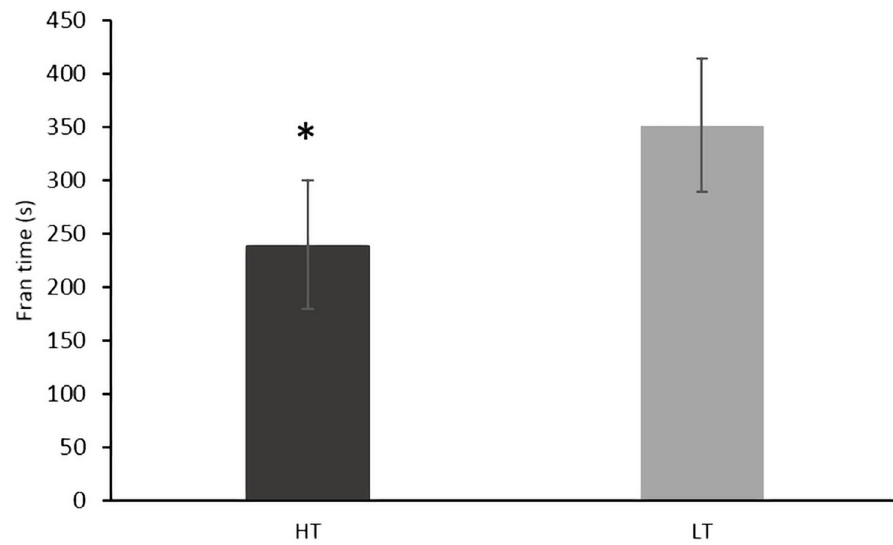
Fig 1. Performance in the “Fran” workout of the day in two groups of CrossFit participants. HT, higher training group; LT, lower training group. � , P < 0.05 vs. LT.